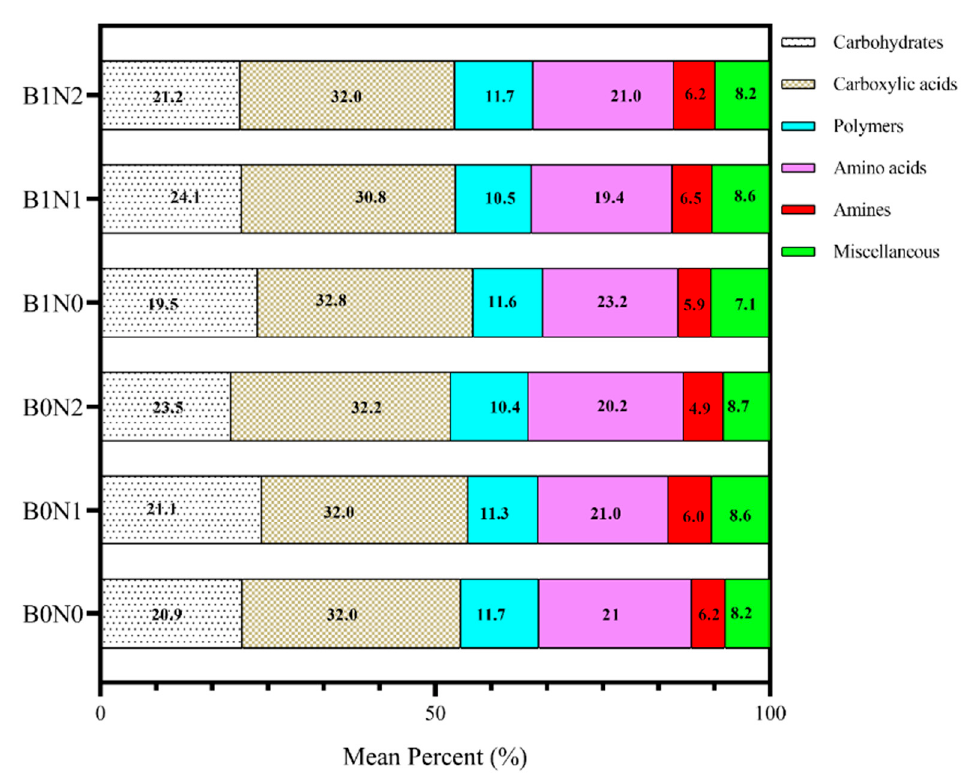
Figure 6. Effect of different treatments on the average mean of soil carbon sources. B0N0 (without biochar or N fertilization); B0N1 (without biochar and with 160 kg · ha − 1 N); B0N2 (without biochar and with 120 kg · ha − 1 N); B1N0 (biochar 25 t · ha − 1 only); B1N1 (biochar 25 t · ha − 1 and 160 kg · ha − 1 N); and B1N2 (biochar 25 t · ha − 1 and 120 kg · ha − 1 N).